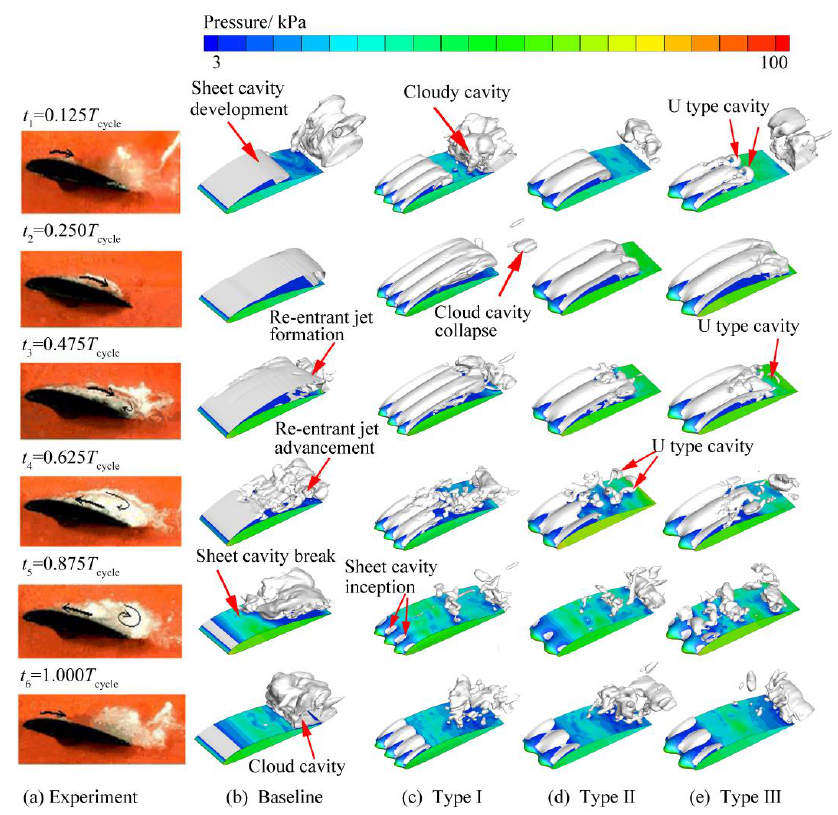
Figure 8. Numerical dimensionless total vapor volume ( V ).